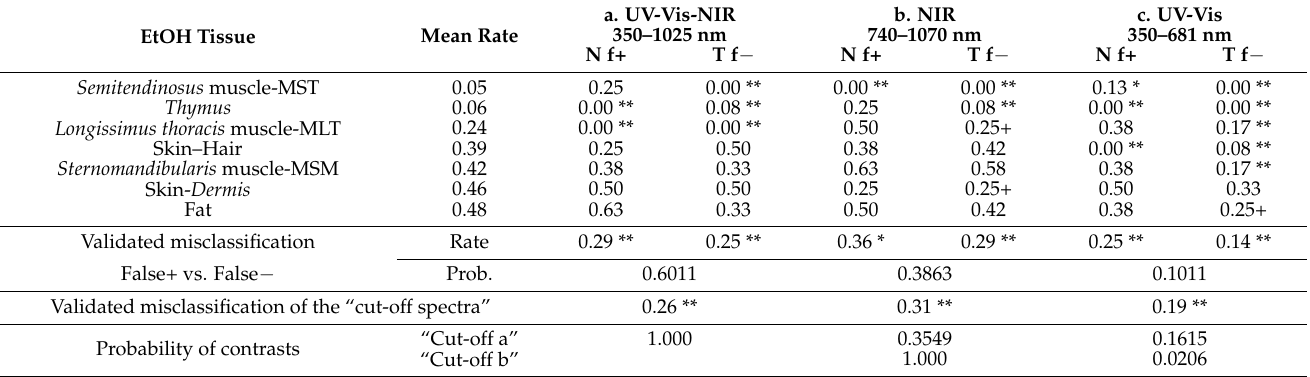
Table 2. Validated misclassification (as the rate) of the control (N, false+, f+) and treated (T, false − , f − ) animals considering the seven tissues in three spectrum subranges of the “cut-off spectra”.